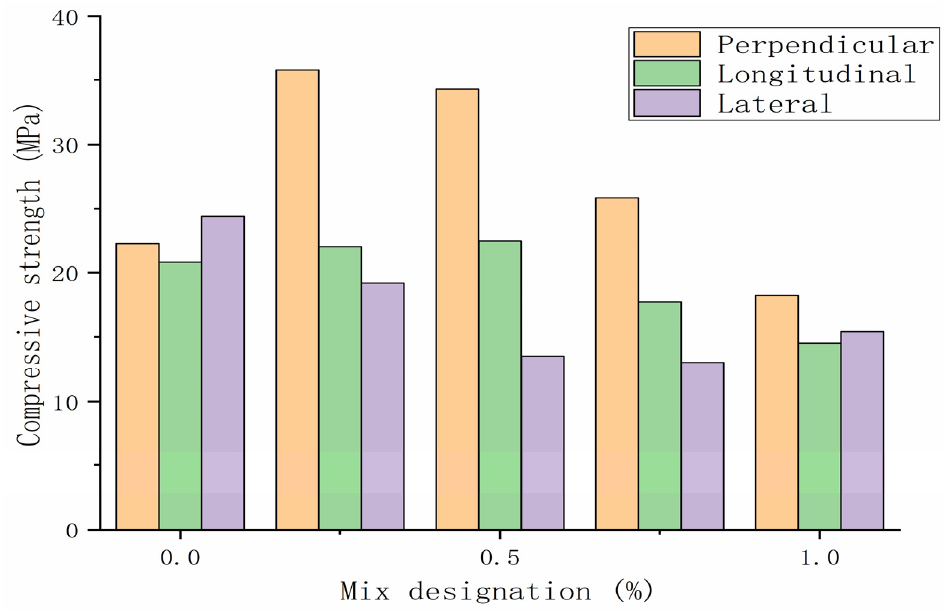
Figure 4. The compressive strength of printed specimens in different directions. Adapted with permission from [62], copyright 2019 Elsevier.